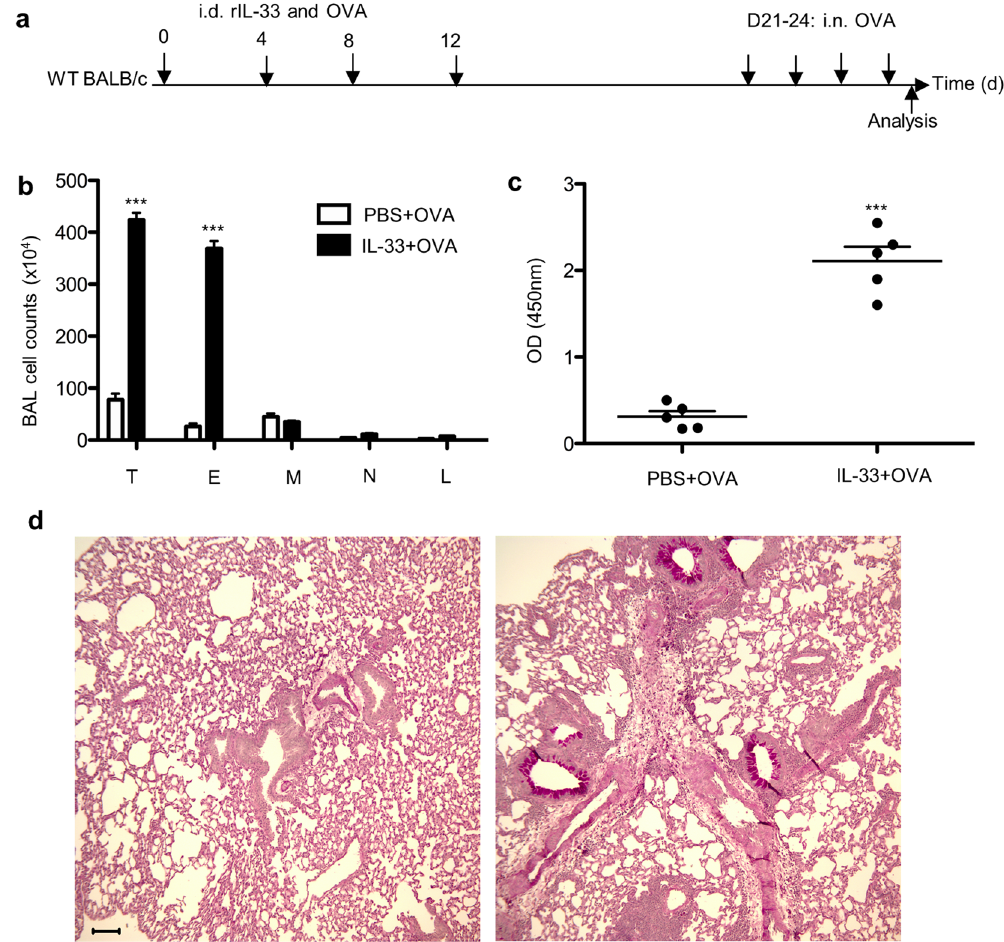
Figure 2. Intradermal administration of IL-33 aggravates airway inflammation and mucus secretion in experimental asthma. ( a ) Experimental protocol. ( b ) Cell counts in the BAL fluid. The significance between two groups was determined by two-tailed Student’s t test. ( c ) OVA-specific IgE on Day 25. ( d ) Representative lung tissue cross-sections stained with PAS to visualize mucus-producing goblet cells and airway inflammation. Left, PBS + OVA; Right, IL-33 + OVA. Bar, 100 µ m. T, total cells; E, eosinophils; M, macrophages; N, Neutrophils; L, lymphocytes. Data are representative of two independent experiments with five mice per group. Error bars indicate the mean ± SD. *** p ≤